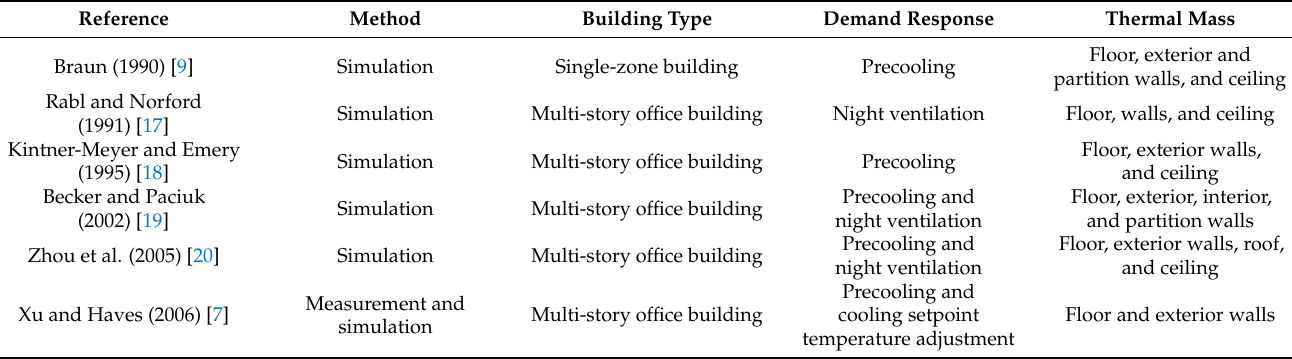
Table 1. Previous demand flexibility studies using thermal